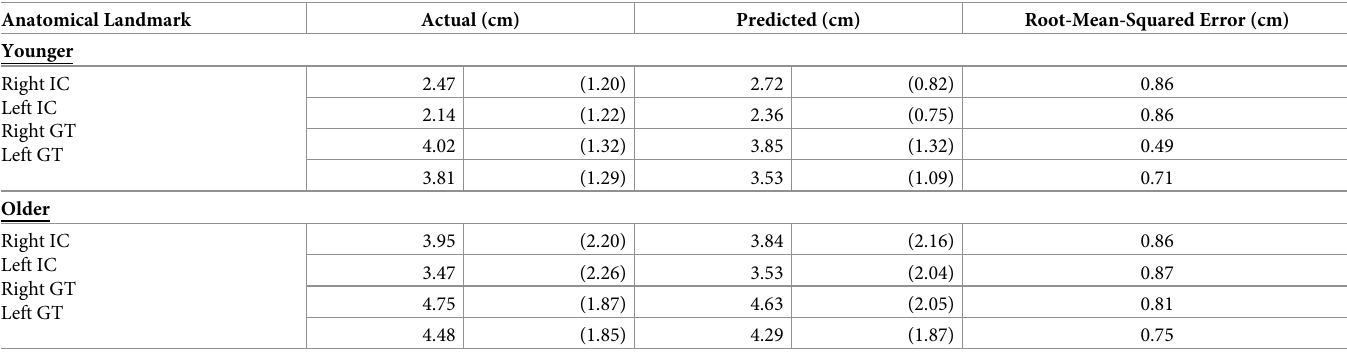
Table 5. Mean ( ± SD) predicted and actual (DXA) soft tissue thicknesses and errors from the younger and older validation sample (n = 26). Anatomical